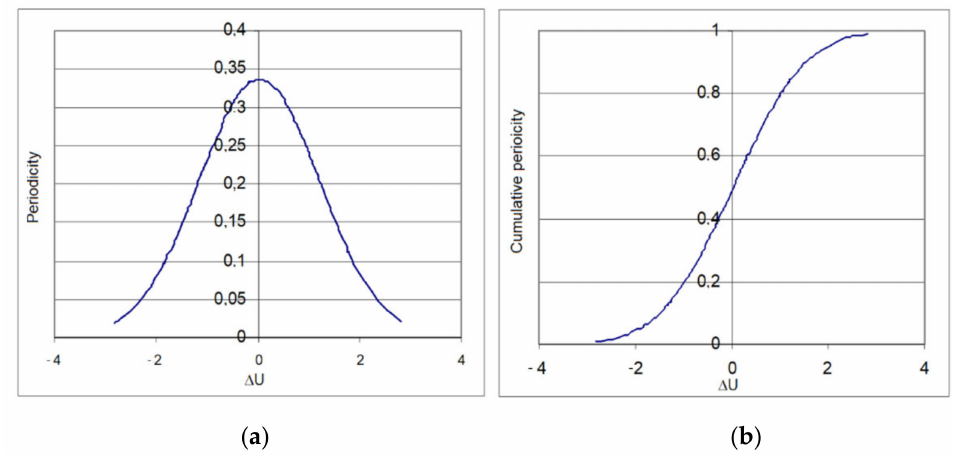
Figure 22. Periodicity expansion ( a ) and distribution function ( b ) as a function of voltage